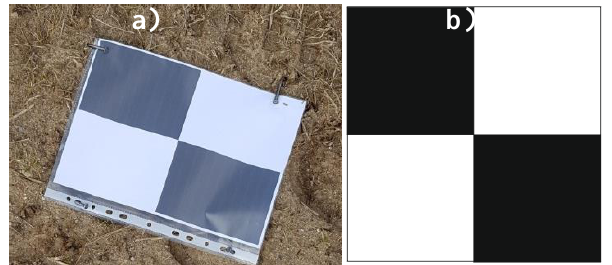
Figure 7. ( a ) Ground Control Point marked in the field with a white and black chessboard; ( b ) Project of the ground control point.